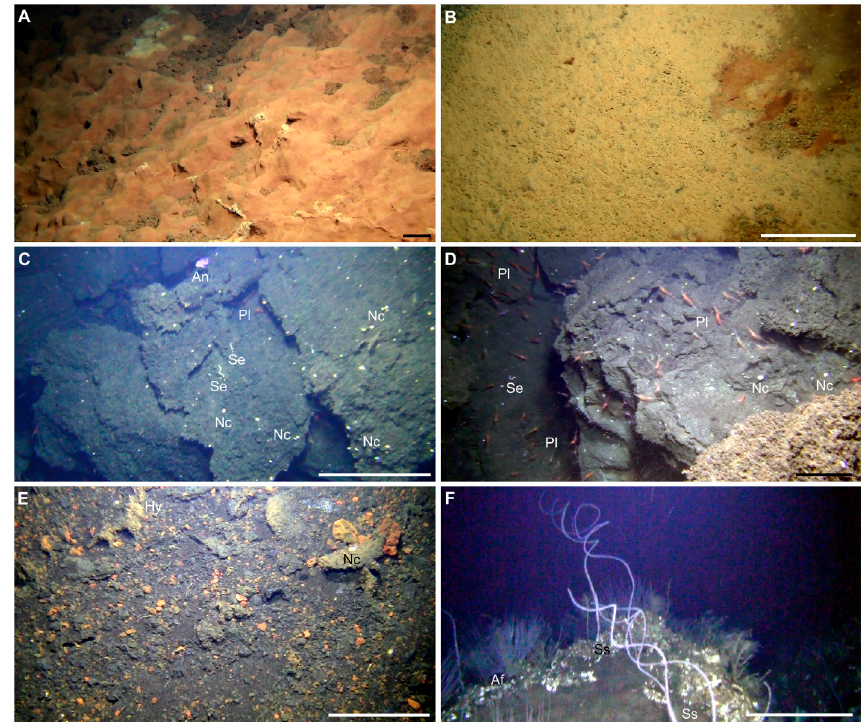
Figure 5. Images of the different habitat types within the Tagoro volcano complex ( A–E ), and at an undisturbed area ( F ). ( A,B ) Seep habitats with extensive bacterial mats close to the main and secondary craters. ( C , D ) Newly formed pyroclastic rocks harboring Neopycnodonte cochlear (Nc) (Mollusca: Bivalvia) and Hyalopomatus sp. (Hy) (Annelida: Polychaeta) individuals, together with Anthias anthias (An) (Chordata: Actinopterygii), and high densities of Plesionika sp. in the crevices (Pl) (Arthropoda: Decapoda). ( E ) New mixed substrates with small rocks colonized by individuals of N. choclear and Hyalopomatus sp. ( F ) Stable undisturbed hard bottoms colonized by fan-shaped Antipathes furcata (Af), and twisted whip-shaped Stichopathes cf. setacea (Ss) (Cnidaria: Anthozoa). Scale bars represent 20 cm.